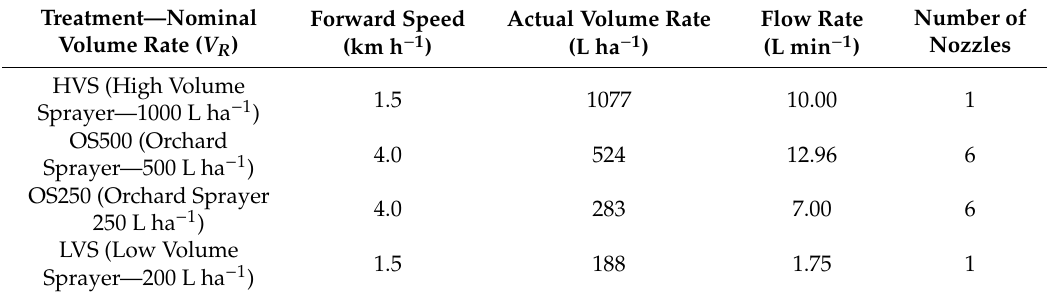
Figure 2. Experimental design. Red circles show sampling vines. Table 1. Forward speed (km h − 1 ), actual volume rate (L ha − 1 ), flow rate (L min − 1 ) and number of nozzles for the four different treatments.